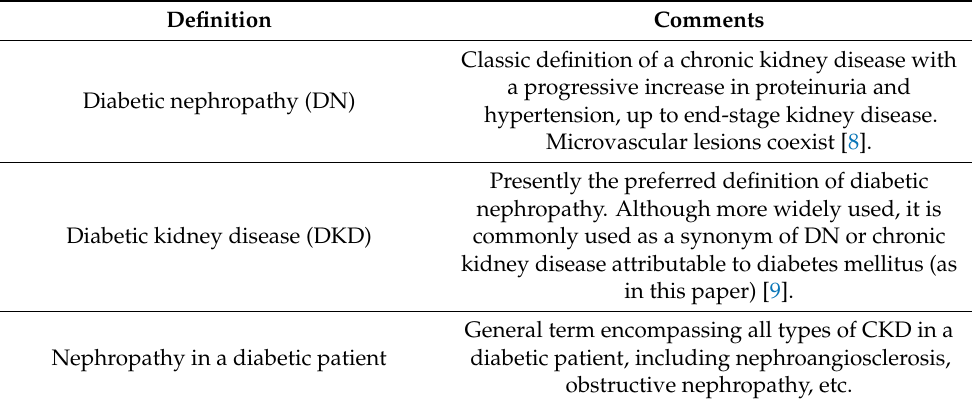
Table 1. Definitions of diabetic and non-diabetic nephropathy in diabetic patients.